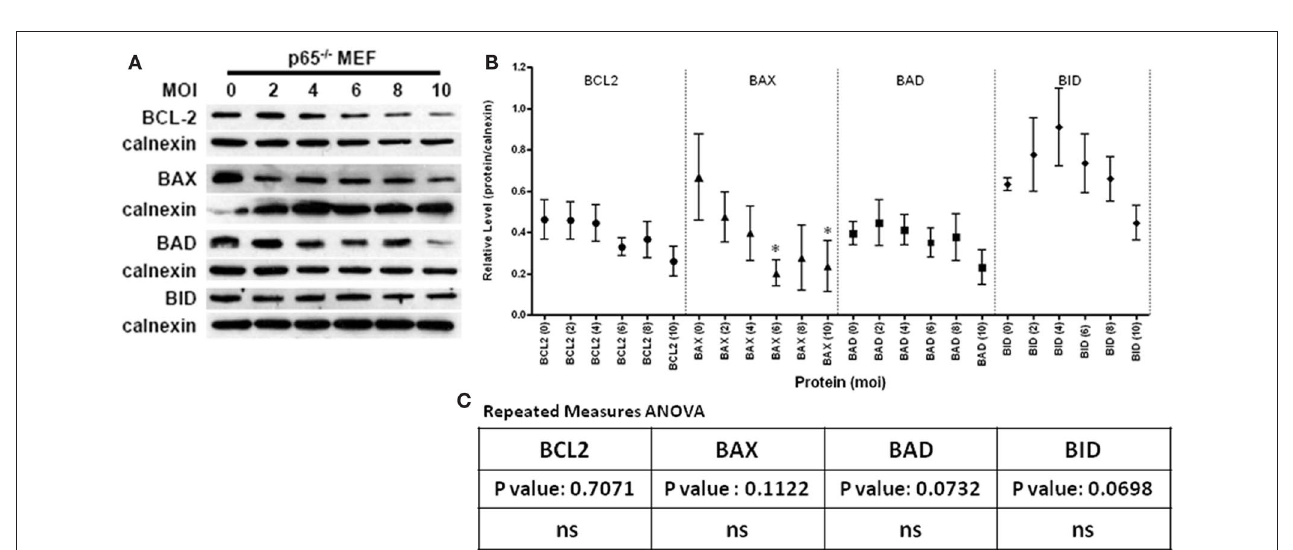
Figure 1 | The effect of Toxoplasma gondii infection on the steady state levels of the BCL2-family proteins in WT MeF. (A) Representative immunoblots detecting the levels of the anti-apoptotic BCL2, pro-apoptotic multi-domain member BAX and the BH3-only proteins BAD and BID in response to increasing infection (multiplicity of infection range 0 (uninfected) to 10). The signal for calnexin is used as a loading control. (B) Quantification of the relative levels of BCL2-family proteins relative to the corresponding signal for calnexin in response to infection at a given MOI. The multiplicity of infection for a given protein is denoted in the parenthesis following the name of the target protein. Using criteria outlined in the Section “Materials and Methods,”